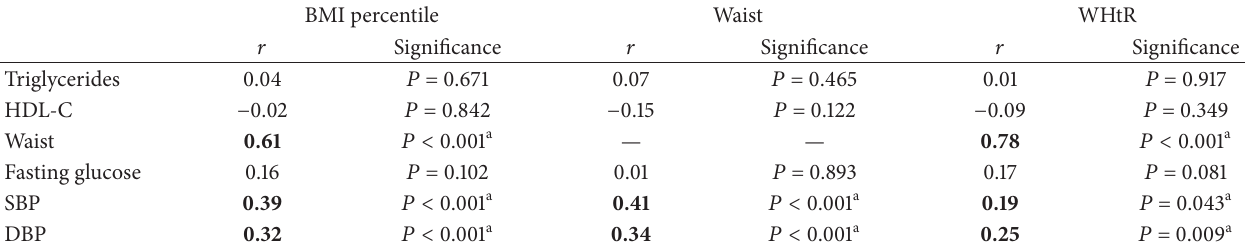
Table 3: Spearman’s correlation coefficients ( 𝑟 ) between the anthropometric indices and components of MS.